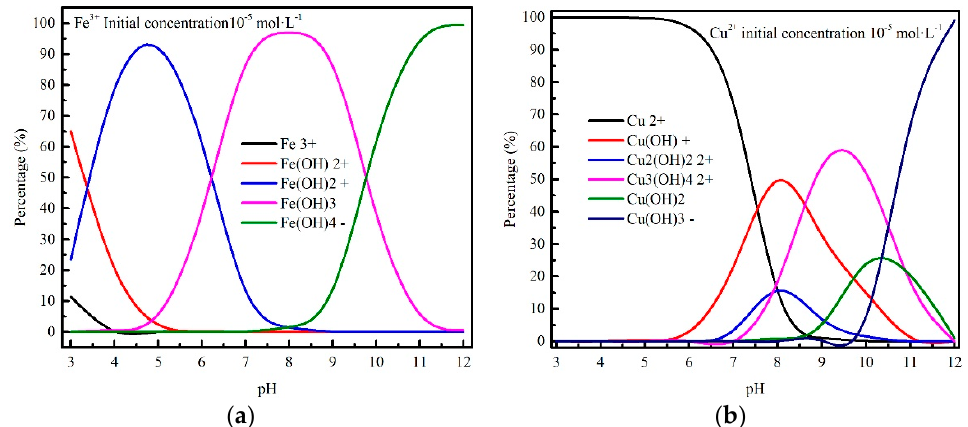
Figure 5. Species of ( a ) ferric ions in solution and ( b ) copper ions in solution.